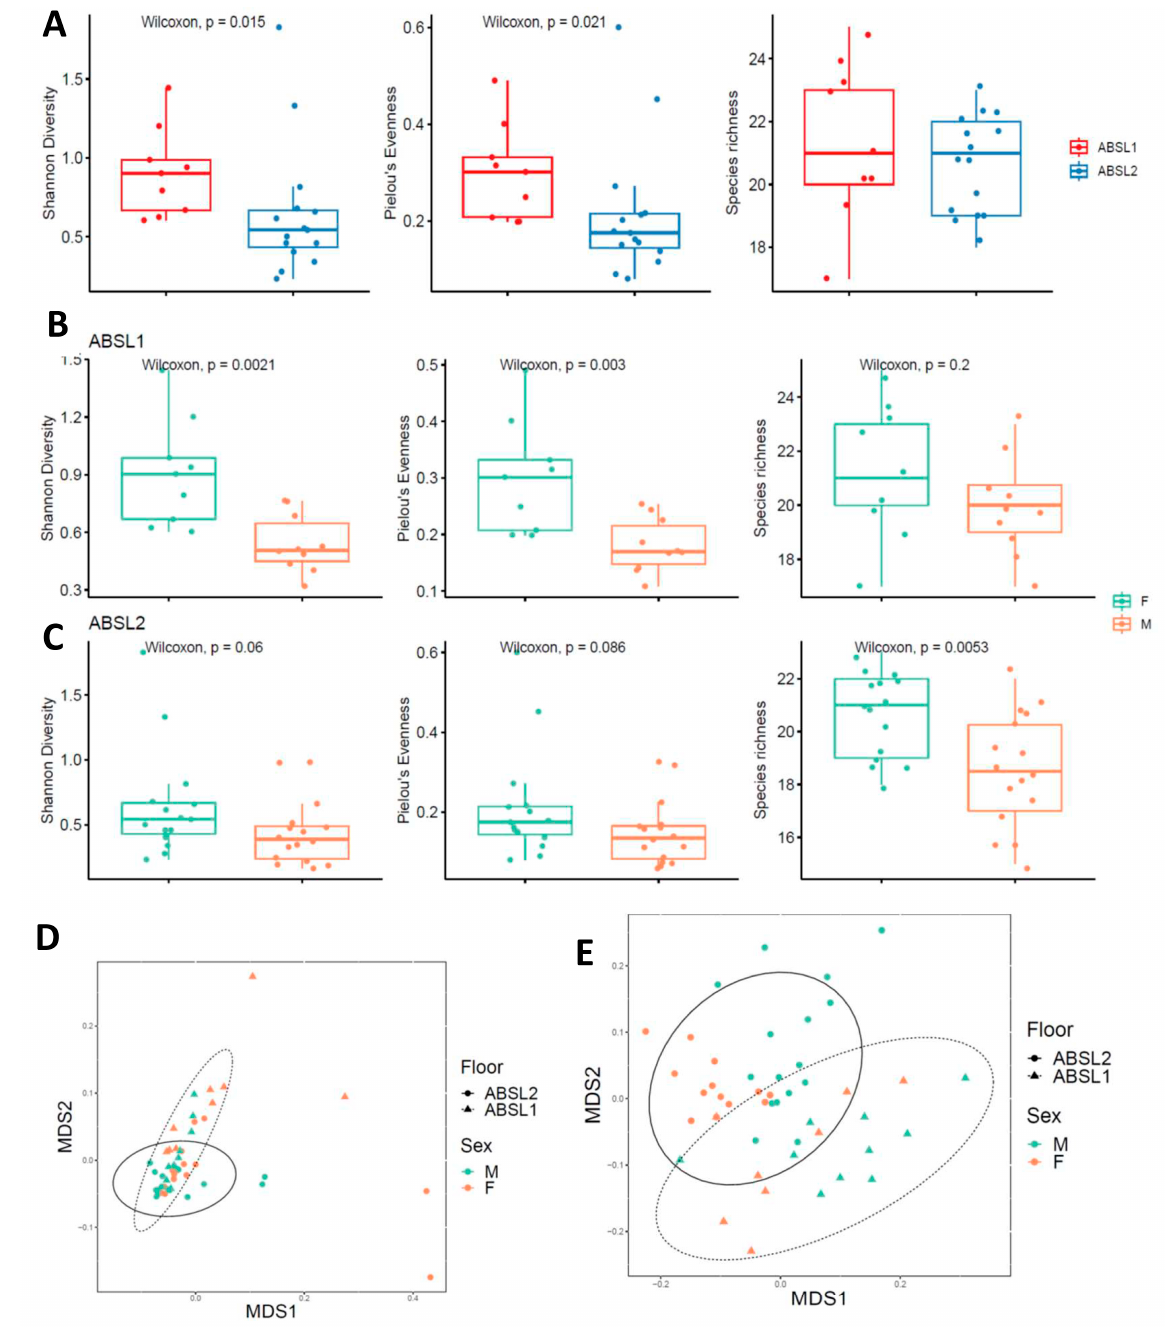
Figure 5. Murine female gut microbial diversity is modified by housing environment. ( A ) Shan- non diversity index, Pielou’s evenness and species richness scores for female mice housed in ABSL-1 and ABSL-2 facilities following bleomycin inoculation ( N = 9–14 mice per cohort). The boxes show the median, as well as the 25th and 75th quartiles. The whiskers extend to 1.5*IQR. Each dot represents one mouse. ( B , C ) Comparison of female and male Shannon diversity index, Pielou’s evenness and species richness scores for female mice housed in ABSL-1 and ABSL-2 facilities following bleomycin inoculation (n =14–16 mice per cohort). ( D ) Nonlinear multidimensional scaling (MDS) plot showing differences in microbial taxonomic composition based on Jaccard dissimilarities. ( E ) Nonmetric multidimensional scaling plot based on Bray–Curtis and Jaccard dissimilarities showing the gut microbiome by gender of murine communities housed on ABSL1 and ABSL2